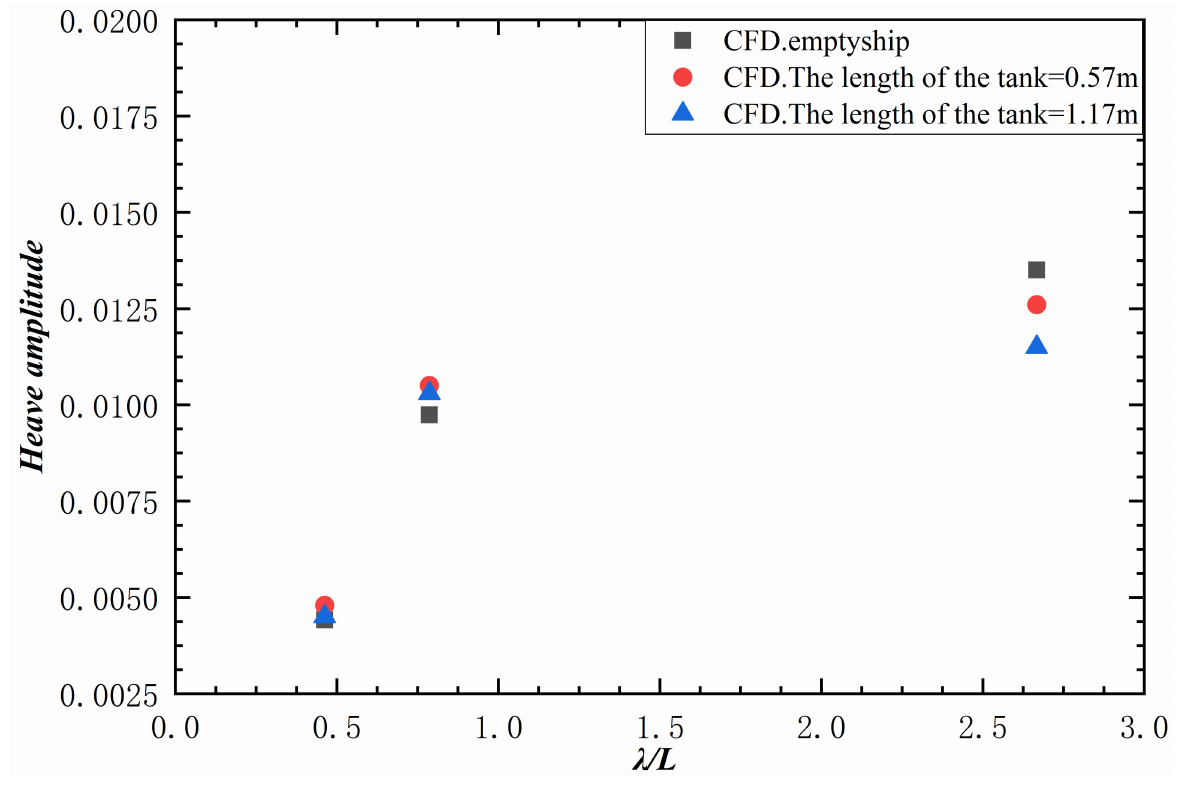
Figure 24. The heave amplitude of the ship.